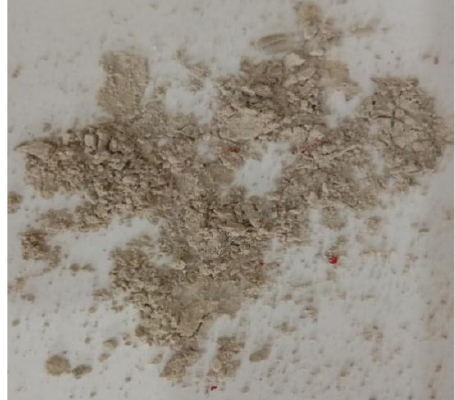
Figure 1. Photograph of incense stick ash collected from a